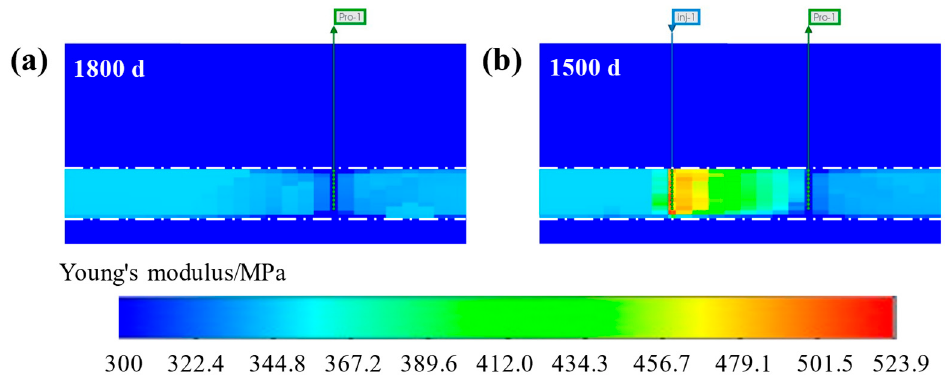
Figure 9. Comparison of the Young’s Modulus in Case A ( a ) and Case B ( b ) with the same C G .